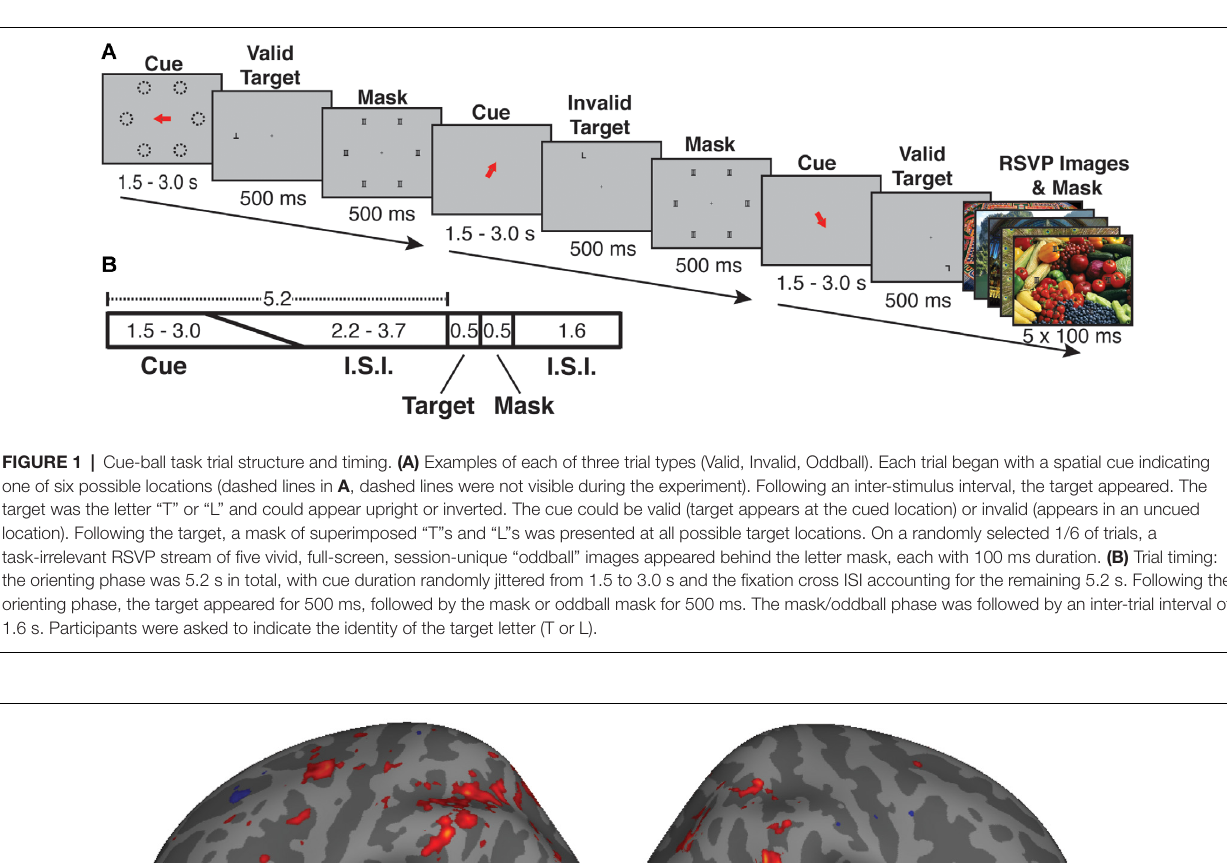
tasks (TR = 2,600 ms, TE = 30 ms, Flip angle = 90 ◦ , voxel size = 3.0 × 3.0 × 3.1 mm, 42 slices,